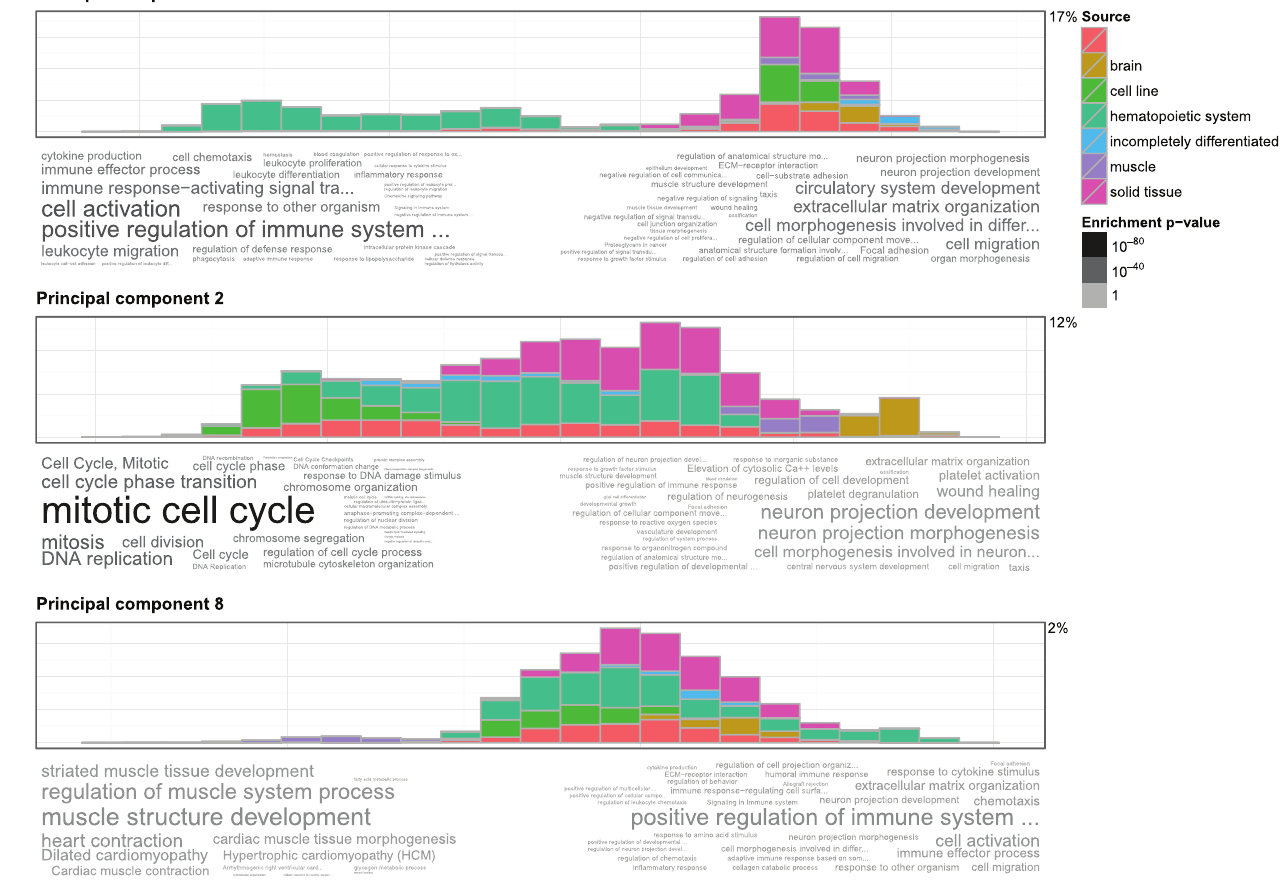
Figure 3. GOsummaries representation of PCA results. Each component is described by a histogram showing the distribution of samples along the principal axis and word clouds showing the GO annotations for most influential genes. The left and right word clouds represent 500 genes with largest negative and positive loadings respectively. The percentages next to histograms show the percentage of variation explained by each